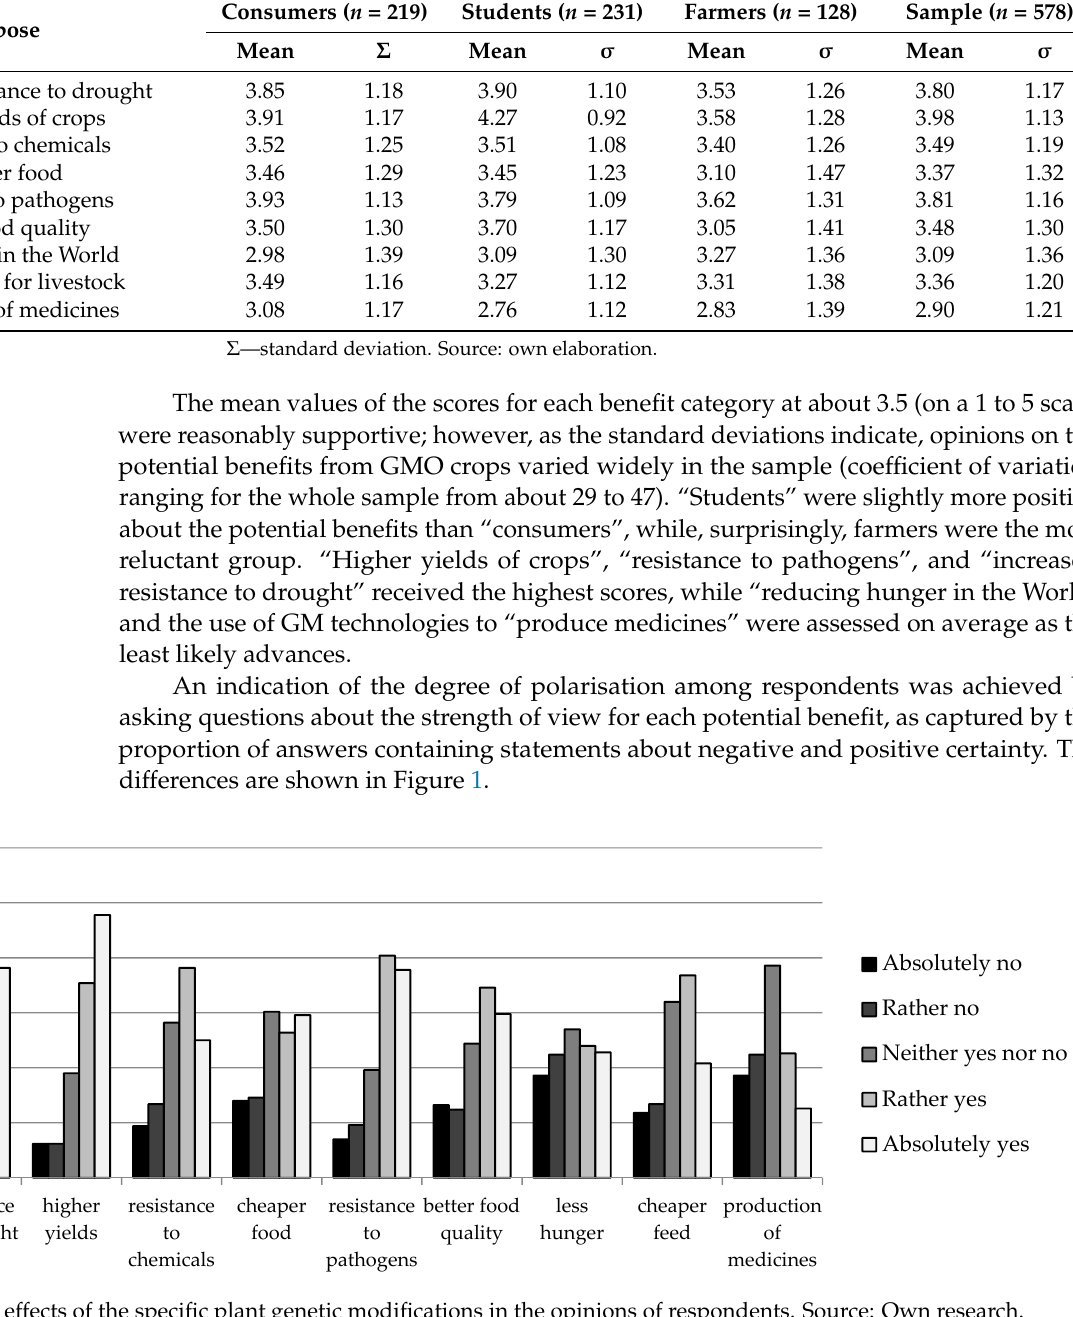
Figure 1. The effects of the specific plant genetic modifications in the opinions of respondents. Source: Own research.